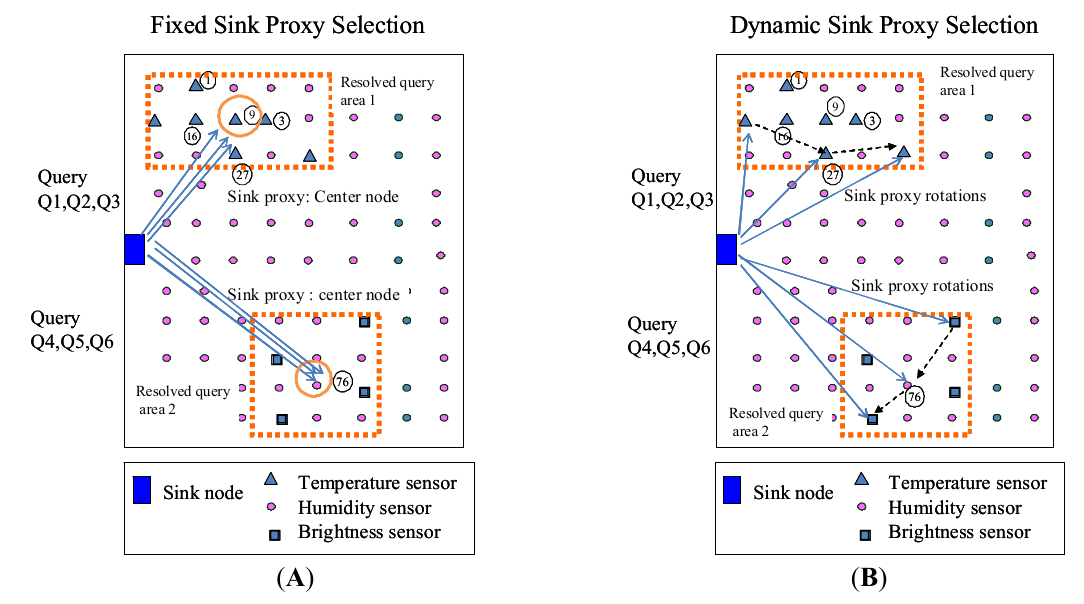
Figure 2. Two Types of Sink Proxy